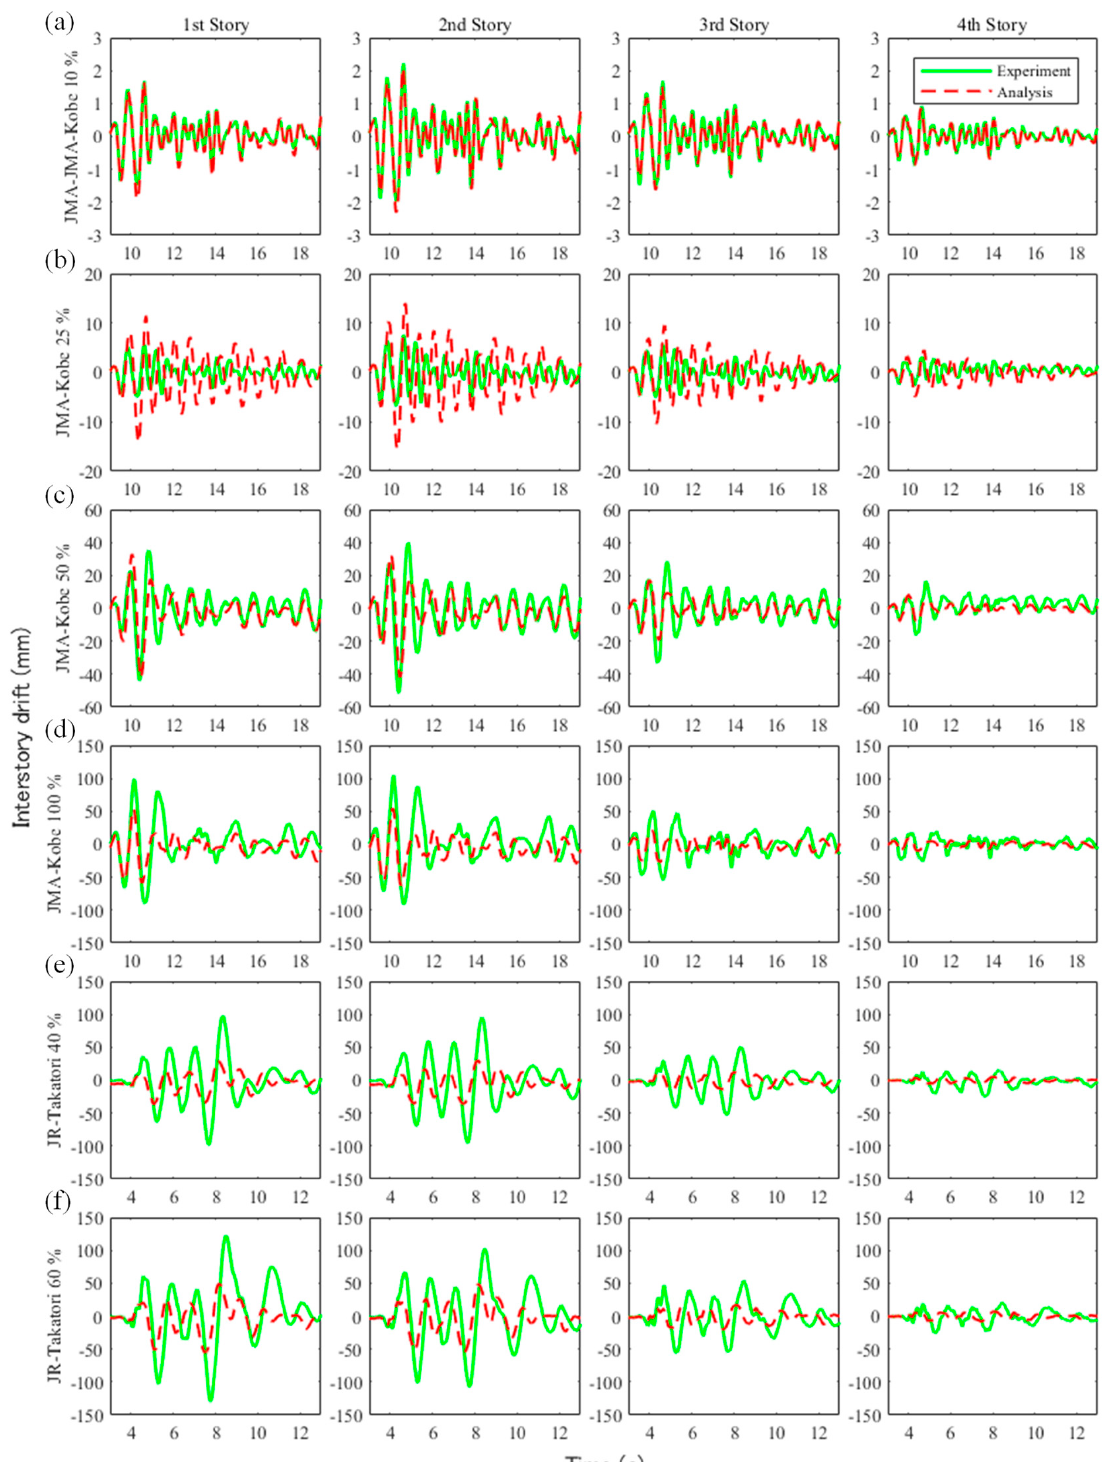
Figure 8. Comparison of the experimental and analyzed inter-story drift results: ( a ) JMA-Kobe 10% amplitude experiment, ( b ) JMA-Kobe 25% amplitude experiment, ( c ) JMA-Kobe 50% amplitude experiment, ( d ) JMA-Kobe 100% amplitude experiment, ( e ) JR-Takatori 40% amplitude experiment, and ( f ) JR-Takatori 60% amplitude experiment. Table 8. Root-mean-square percentage error for maximum floor acceleration and maximum inter- story drift ratio (experimental and analyzed results, unit: %). Maximum Floor Maximum Inter-Story Drift Test No. Input Wave Acceleration